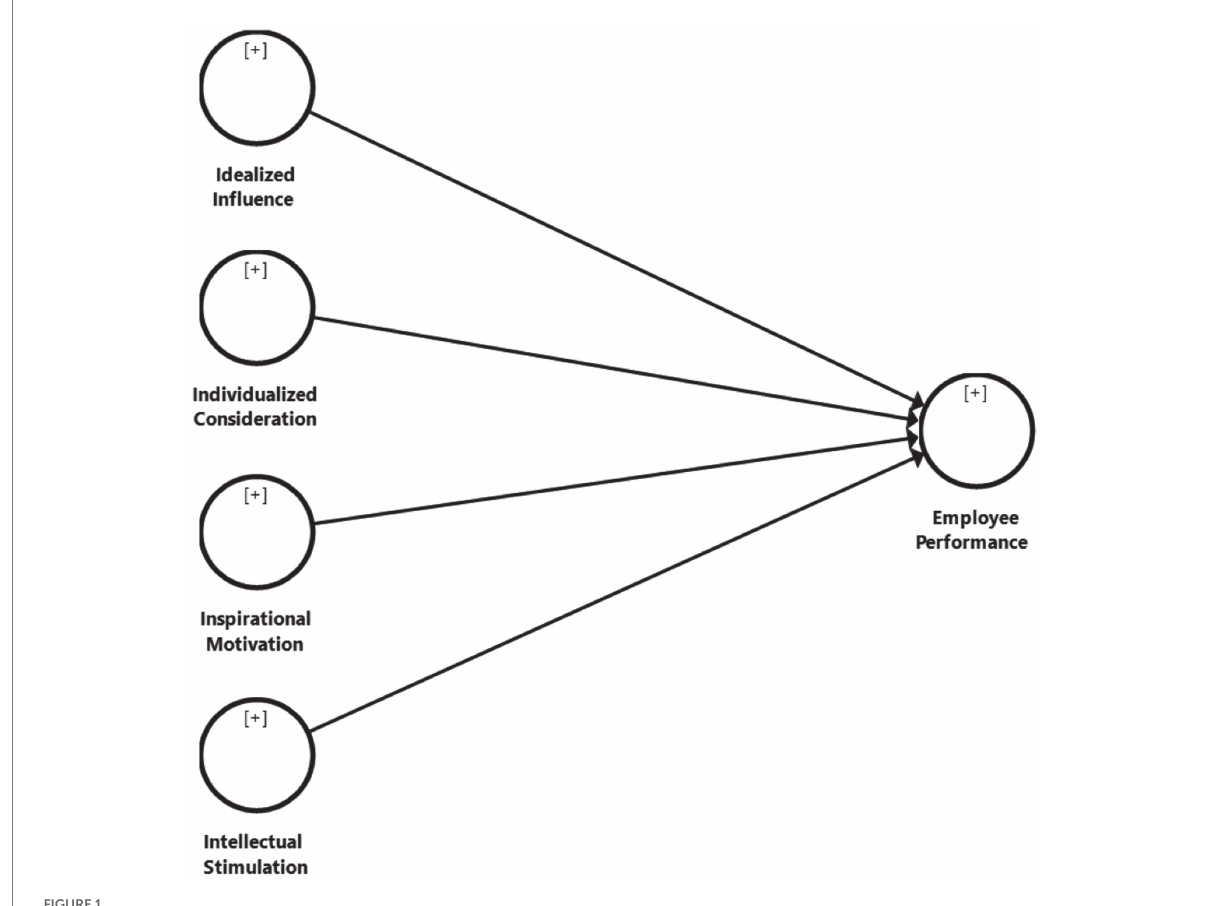
FIGURE 1 Research